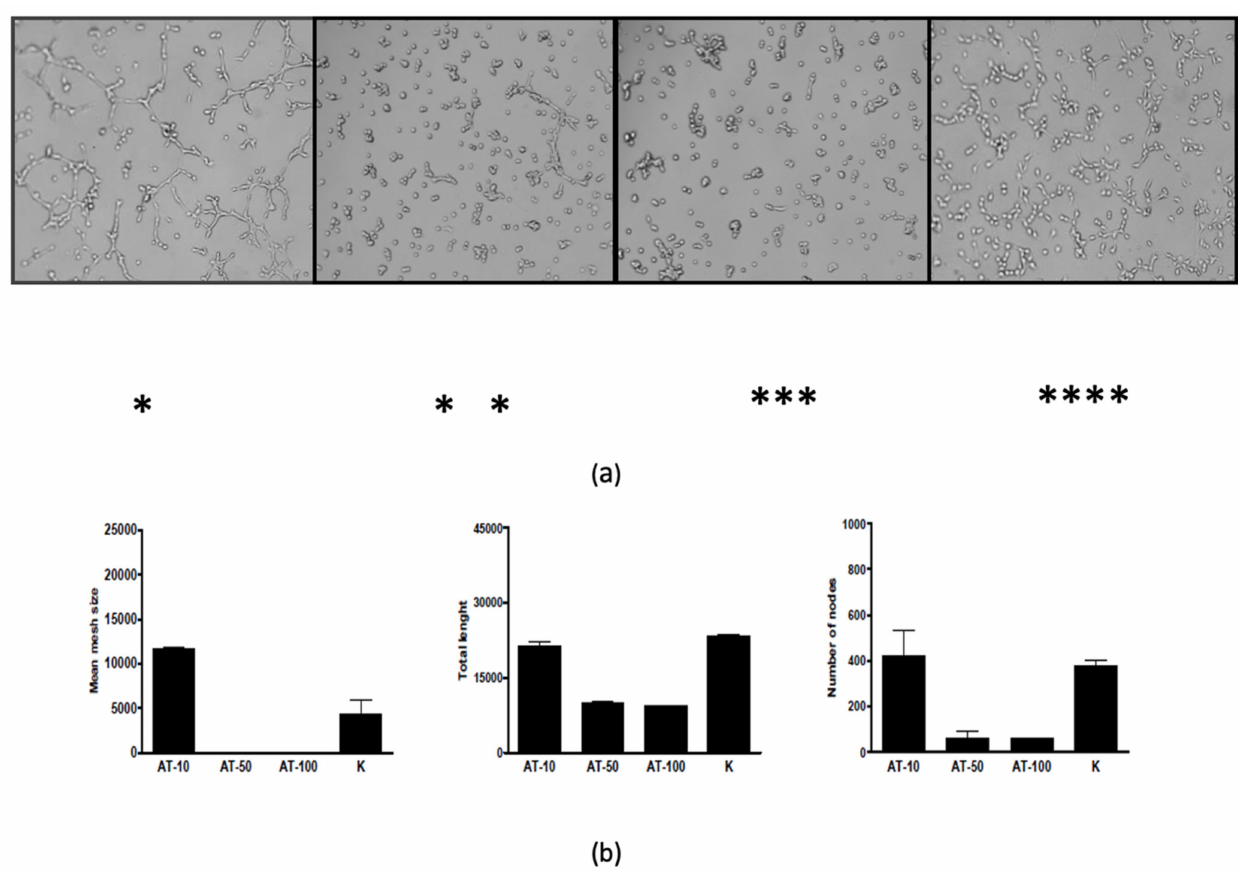
Figure 14. The influence of the HATMSC1 line supernatant on angiogenic activity of skin endothelial cell line HSKMEC.2. ( a ) Pictures taken 14 h after plating HSkMEC.2 cells on Matrigel in DMEM culture medium supplemented with * 10% (AT-10), ** 50% (AT-50) *** 100% (AT-100) HATMSC1 supernatant and **** in with 10% FCS (K). ( b ) Influence of the supernatant on endothelial cells, was evaluated using three selected parameters: mean mesh size, total length and number of nodes. Data represents mean ± SEM of one representative experiment, n = 3. *** p <